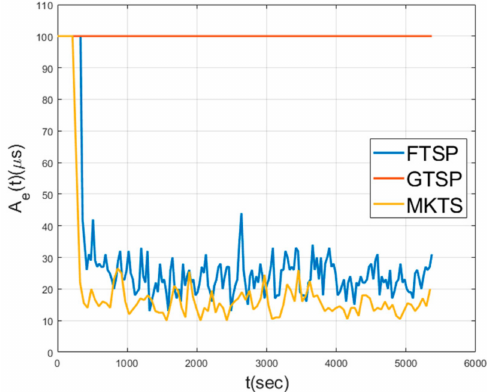
Figure 8. Network error in mobile environment.